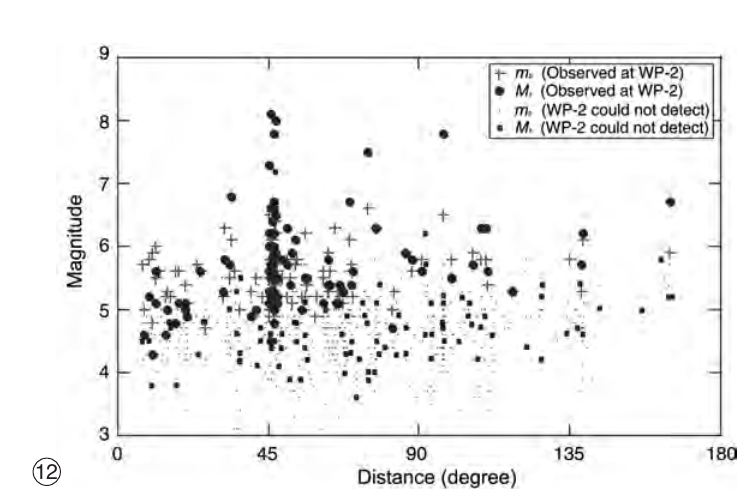
Fig. 11. The records of earthquakes observed si- multaneously by both the WP-1 ( upper ) and the WP- 2 ( lower ) observatories. A one hour records of all the component from 16:00:00,April 26, 2002 are shown. No filter is applied. The earthquake occurred in Mar- iana region and its magnitude was 6.6. Fig. 12. Magnitude distribution of earthquakes rec- orded by the WP-2 Observatory from October 29, 2000 to January 21, 2001 with epicentral distance (large symbols). Plus signs and dots refer to body wave mag- nitude determined by the USGS. Solid circles and squares relate to surface wave magnitude. Small dots and squares denote the magnitude of earthquakes by the USGS, which were not detected by the WP-2 Ob- servatory. Almost all events with magnitudes greater than 5 are observed in the borehole